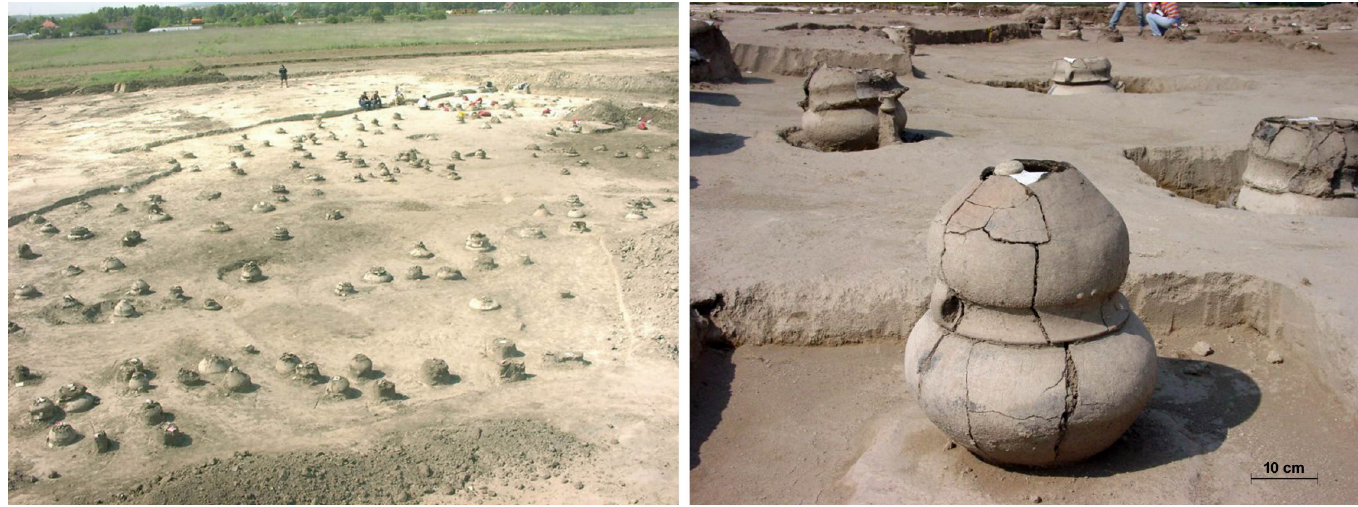
Fig 2. Szigetszentmiklo´s-U¨rgehegy ‘urnfield’ during excavation and a typical Vatya burial.